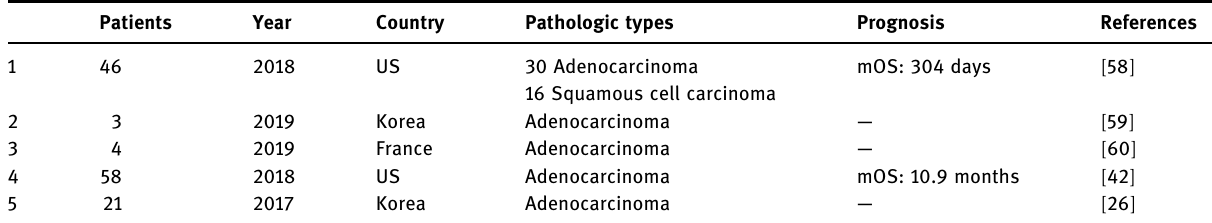
Table 1: Characteristics of fi ve retrospective studies